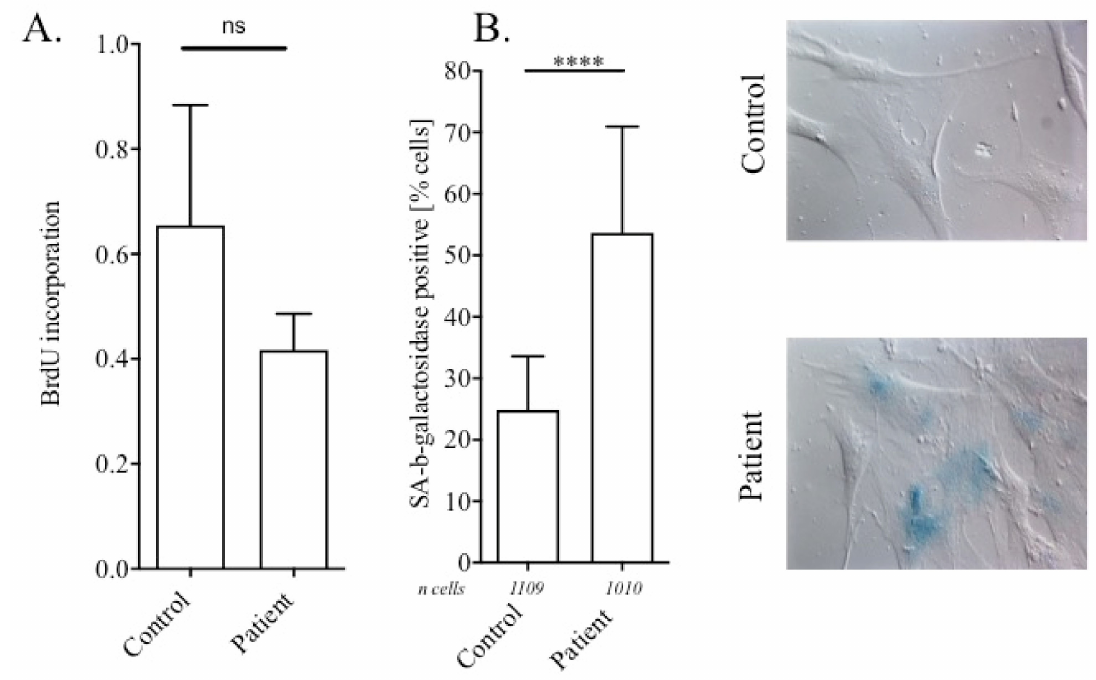
Figure 3. LMNB2 p.(Arg234Trp) mutation induces premature cell senescence. ( A ) Proportion of proliferative cells by BrdU incorporation during 24 h for control and patient fibroblasts. Mean +/ − standard deviation (SD) of four independent experiments; ns compares control with patient condition by the Mann–Whitney test. ( B ) Left panel: percentage of SA-beta-galactosidase positive cells stained in blue. Mean +/ − SD of four independent experiments. ****, p < 0.0001 compares patient with control condition by the Fisher exact test. Right panel: representative pictures of control and patient